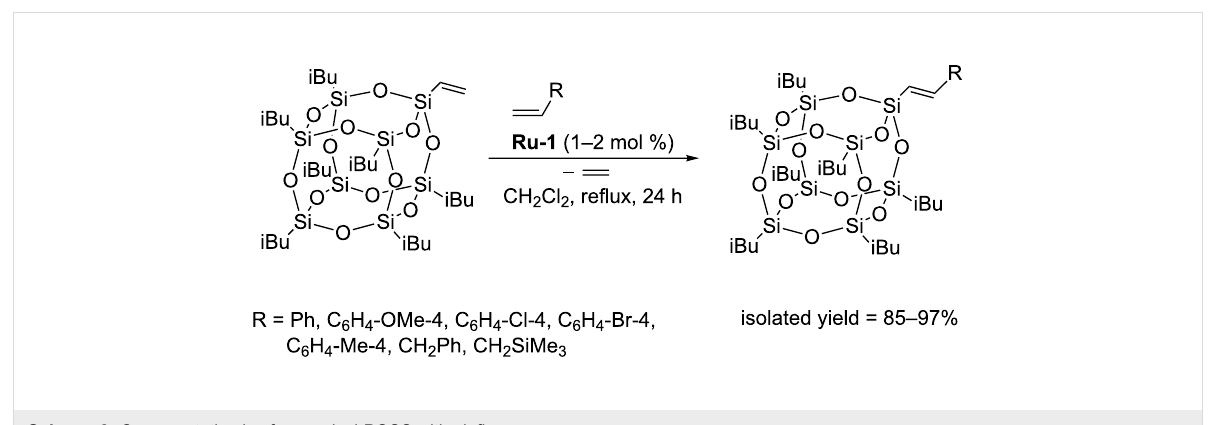
Scheme 8: Cross metathesis of monovinyl-POSS with